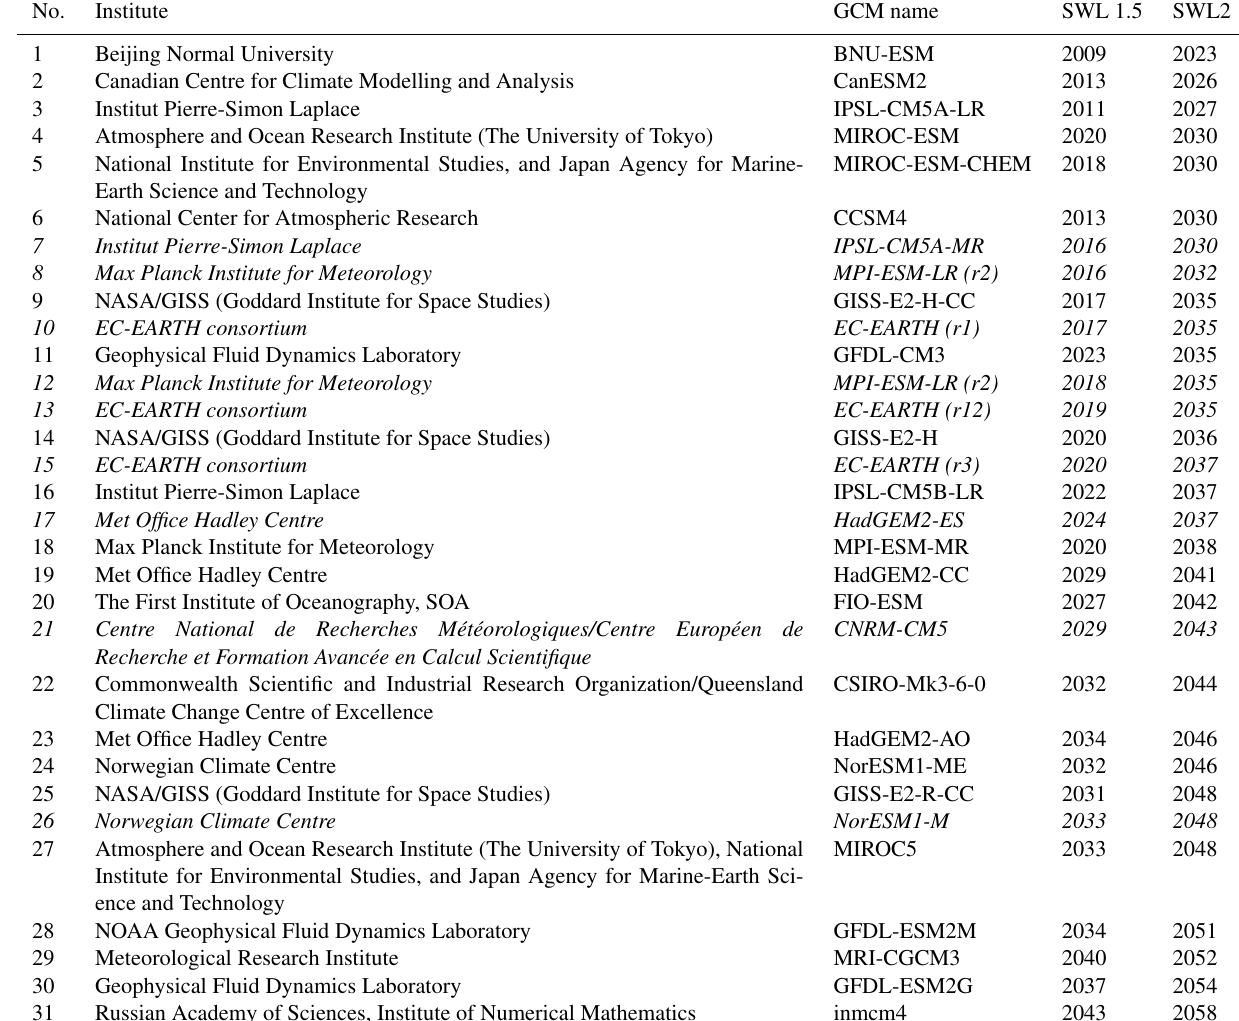
Table 2. CMIP5 GCMs assessed here. Columns SWL1.5 and SWL2 show the central year in a 30-year period when GCMs reach the 1.5 and 2 ◦ C of warming levels (i.e. 2030 represents 2016–2045) under RCP8.5. GCMs are listed in order of when they reach SWL2. Only ensemble member r1 has been used unless otherwise noted in brackets after the GCM name. GCMs in italics have been downscaled by RCMs (see Table 1). For more information see Taylor et al. (2012) and https://pcmdi.llnl.gov/mips/cmip5/ (last access: 27 April 2018).